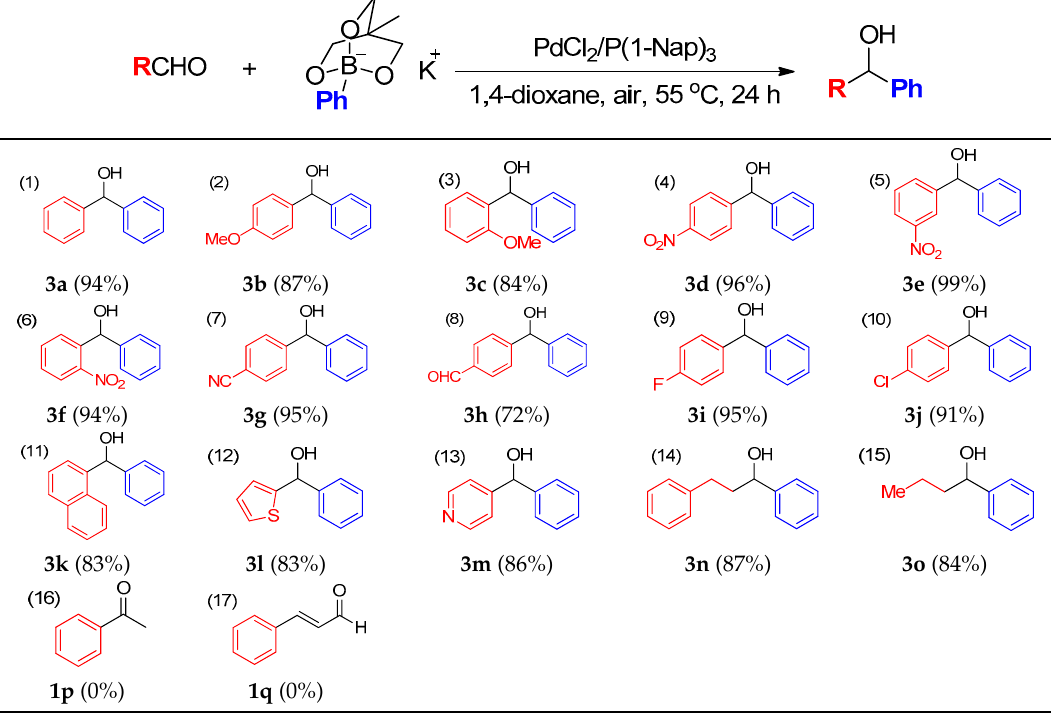
Table 2. Addition of various aldehydes with phenyltriolborate a .